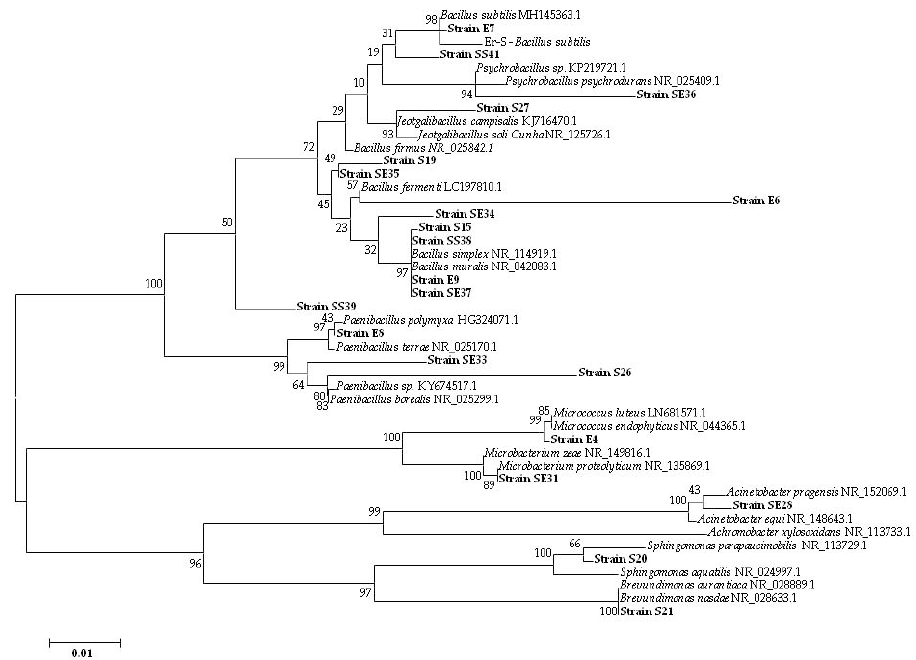
Figure 2. Maximum likelihood tree of endophytic bacteria inferred from the 16S rDNA data set. The sequences generated in this study are in bold type letter. The numbers at the nodes represent bootstrap support values as a percentage of 1000 replicates. The scale bar represents the average number of nucleotide substitutions per site.